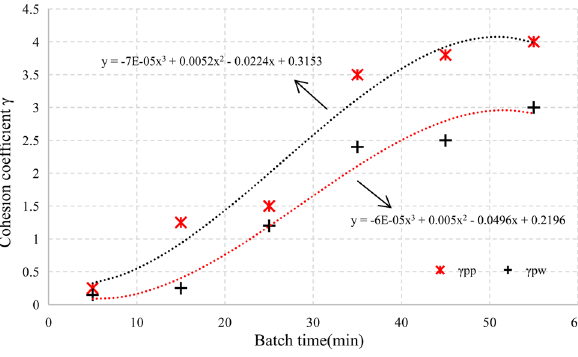
Figure 12: Variation of the cohesion coe ffi cient at di ff erent batch